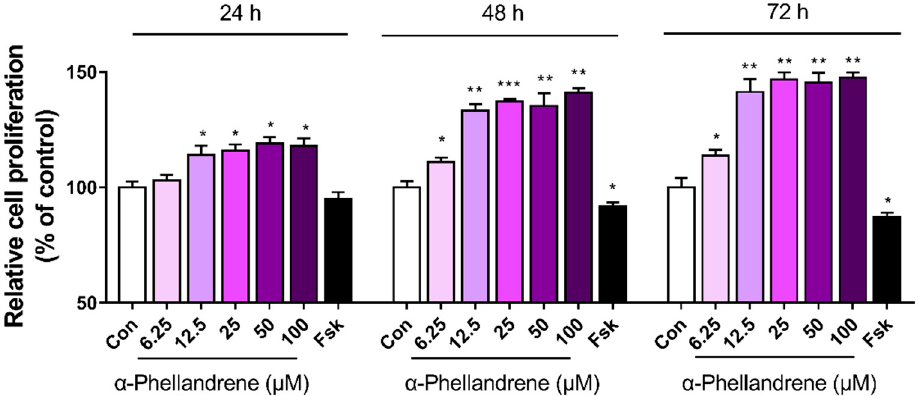
Figure 2. α -phellandrene promotes cell proliferation in dermal papilla cells (DPCs). DPCs were cultured for 24, 48, and 72 h with vehicle (dimethyl sulfoxide; DMSO) as a control (Con), five different α -phellandrene concentrations (6.25, 12.5, 25, 50, and 100 µ M), or 10 µ M forskolin (Fsk). Cell proliferation was measured using a water-soluble tetrazolium salt (WST-1). Results are shown as mean ± standard error of the mean (SEM) of three independent experiments. Statistically significant differences are marked as * p < 0.05 and ** p < 0.01, *** p < 0.001 vs. control (Con).